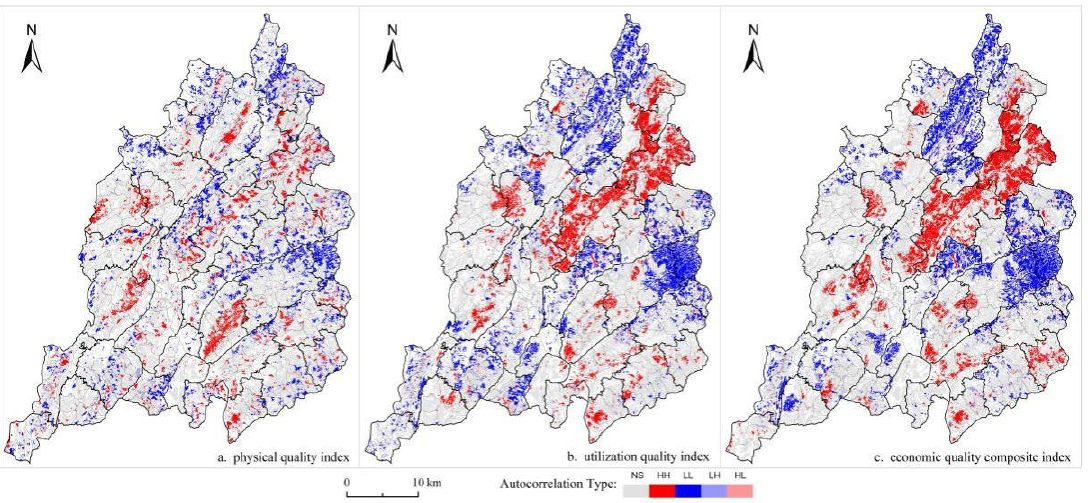
Figure 5. Cluster map of cultivated land quality index of study area.